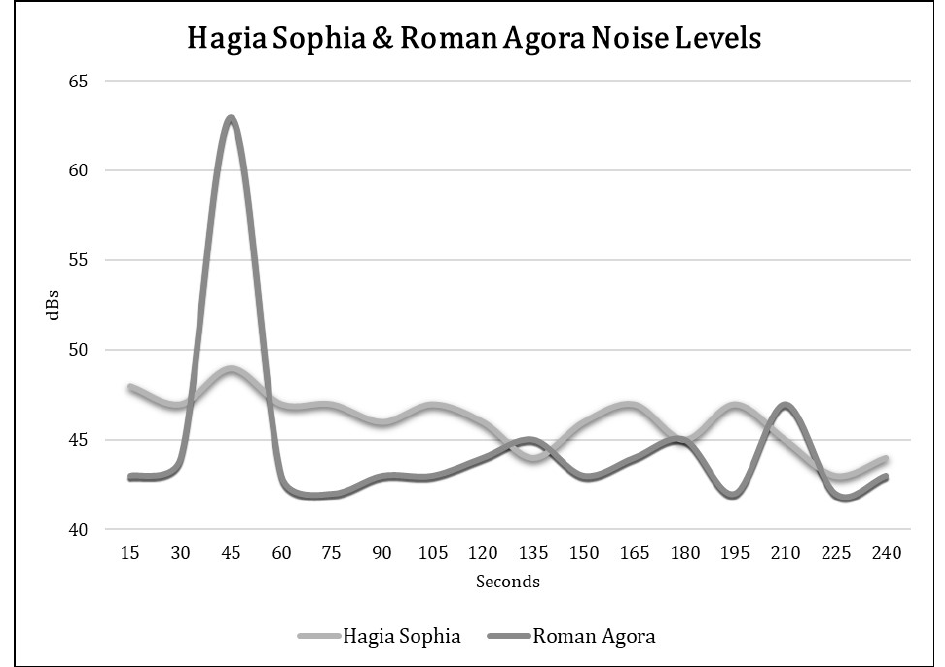
Figure 8. A graph showing levels of noise (dB) in the Roman Agora and Hagia Sophia Square. The Roman Agora had lower noise levels than the terrace in Hagia Sophia Square.